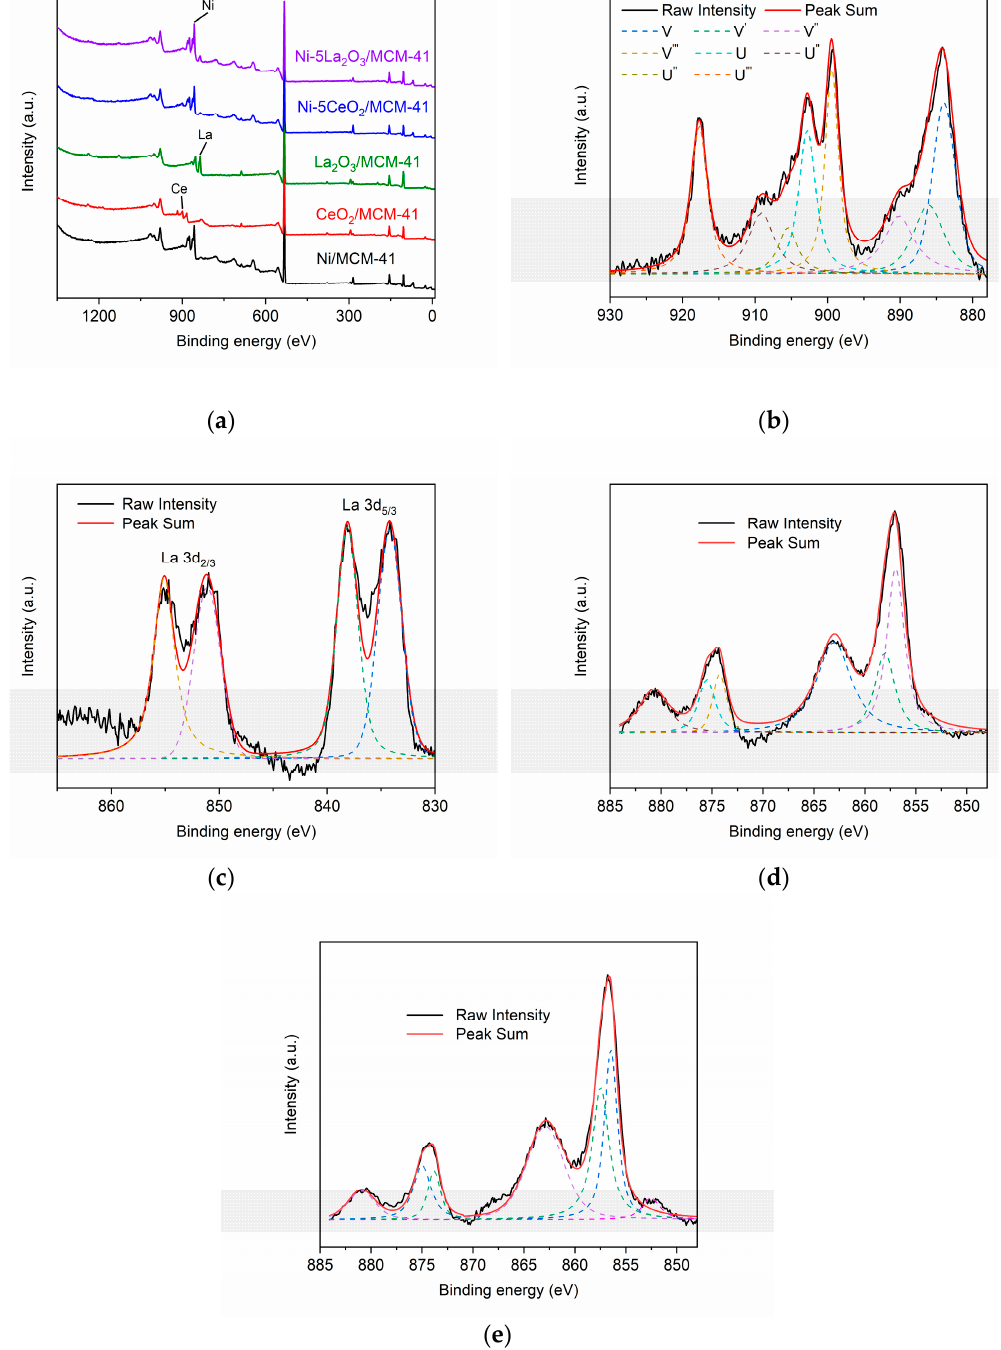
Figure 5. Wide X ‐ ray photoelectron spectroscopy (XPS) spectra of the synthesized catalysts (a); high ‐ Figure 5. Wide X-ray photoelectron spectroscopy (XPS) spectra of the synthesized catalysts ( a ); resolution Ce 3d XPS spectra of Ni ‐ 5CeO 2 /MCM ‐ 41 (b); La 3d XPS spectra of Ni ‐ 5La 2 O 3 /MCM ‐ 41 (c); high-resolution Ce 3d XPS spectra of Ni-5CeO 2 /MCM-41 ( b ); La 3d XPS spectra of Ni-5La 2 O 3 /MCM-41 and Ni 2p XPS spectra of Ni ‐ MCM ‐ 41 (d) and Ni ‐ 5CeO 2 /MCM ‐ 41 (e). ( c ); and Ni 2p XPS spectra of Ni-MCM-41 ( d ) and Ni-5CeO 2 /MCM-41 ( e